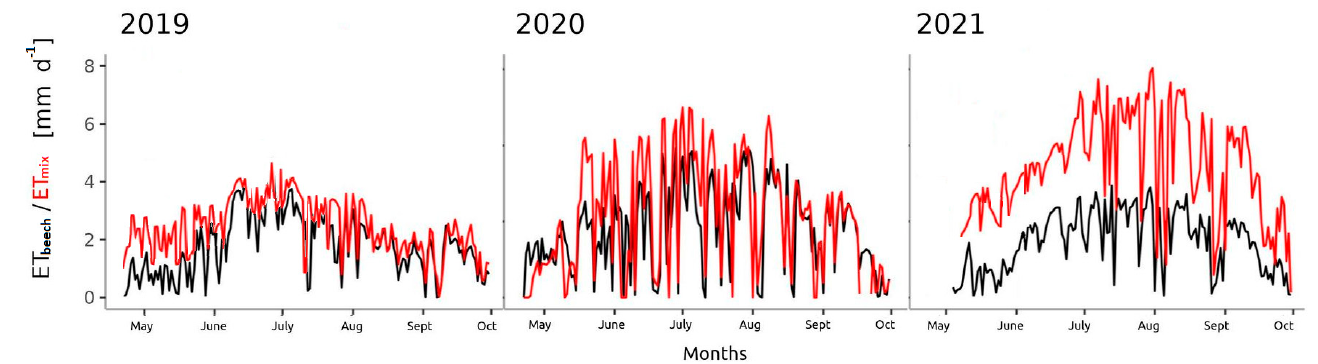
Figure 4. Transpiration (ET) within the monoculture (ET beech ) and mixed (ET mix ) forests.